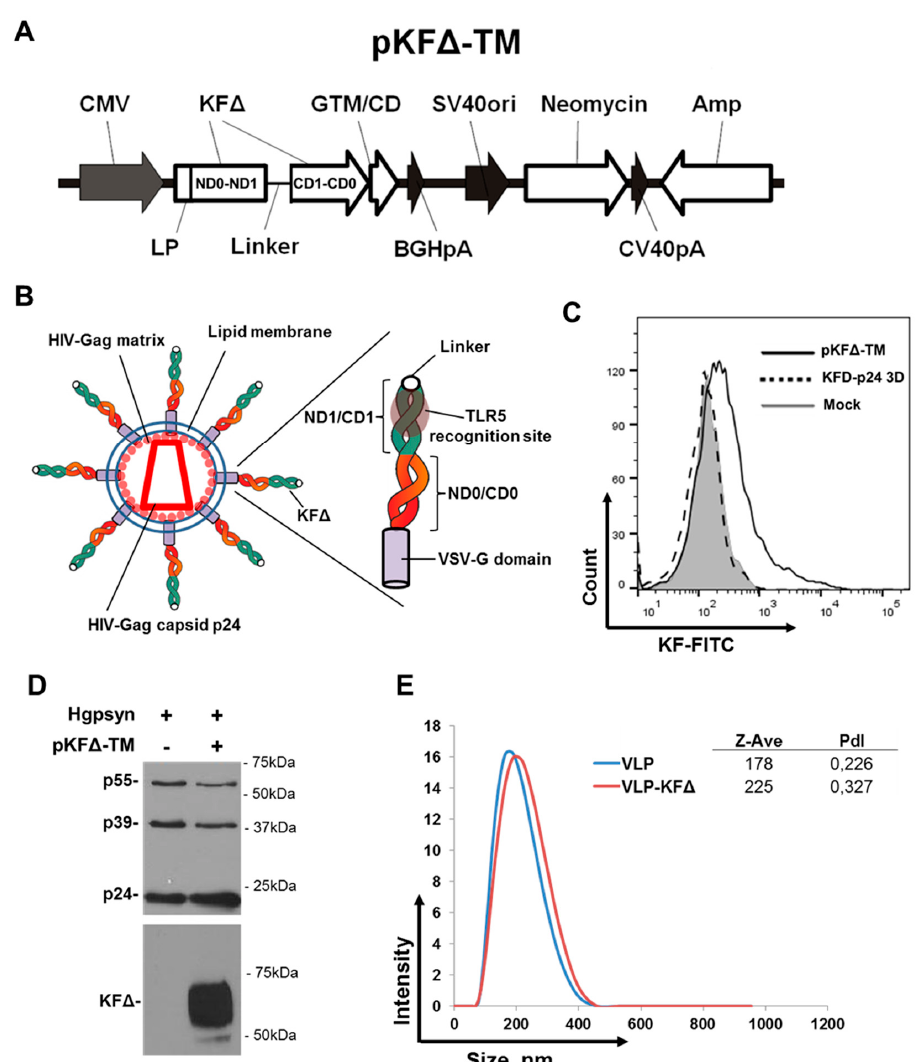
Figure 1. Membrane-anchored form of KF Δ for HIV-VLP functionalization. ( A ) Schematic representation of the pKF Δ -TM plasmid. Amp: Ampicillin resistance; BGHpA: Bovine growth hormone polyadenylation signal; CD: Cellular domain of VSV-G; CMV: Cytomegalovirus promoter; GTM: Transmembrane domain of VSV-G; LP: Leader peptide of VSV-G; SV40ori: Simian virus 40 promoter; SV40pA: Simian virus 40 polyadenylation signal. ( B ) Diagram of HIV-based VLP with membrane-anchored KF Δ (VLP-KF Δ ) and single membrane-anchored KF Δ domain. ( C ) FACS analysis of 293T cells stained for the presence of KF protein on the cell surface two days after transfection with the expression plasmid pKFD-p24 3D or pKF Δ -TM encoding a soluble or a membrane-anchored KF Δ protein, respectively. ( D ) 293T cells were co-transfected with Hgpsyn alone or together with pKF Δ -TM plasmid. Pelleted nanoparticles obtained by ultracentrifugation of the conditioned media were analyzed for the presence of KF and HIV-Gag proteins by Western blot analyses. ( E ) Dynamic light scattering data of VLP and VLP-KF Δ particles with average particle diameter in nm (Z-ave) and polydispersity index (PdI).